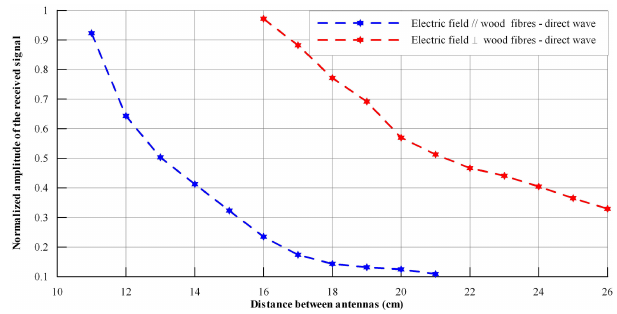
Figure 8. Amplitude of the signal received by the GPR, as a func- tion of the distance between transmitting and receiving antennas (WARR method, 18.18% humidity by mass water).